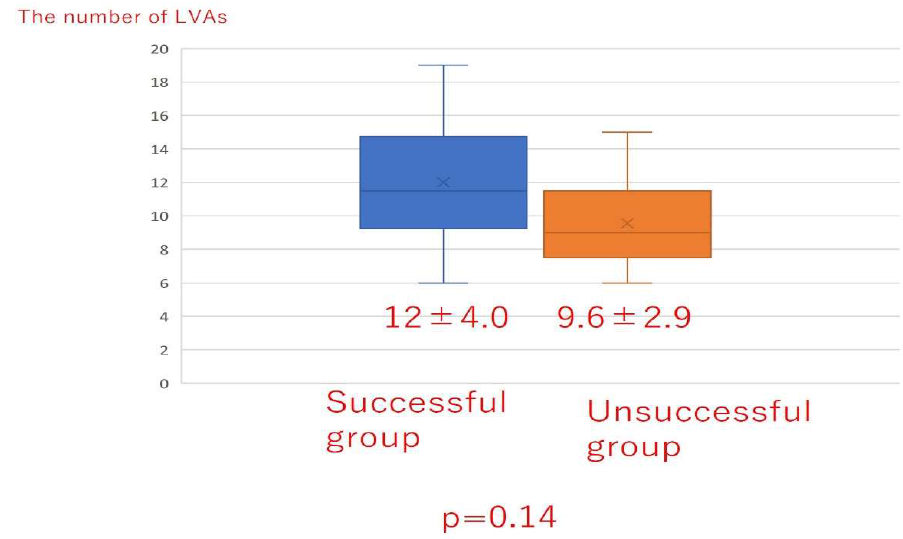
Figure 11. The total number of LVAs in each lower limb according to whether liposuction was successful or unsuccessful. LVA; lymphovenous anastomosis.